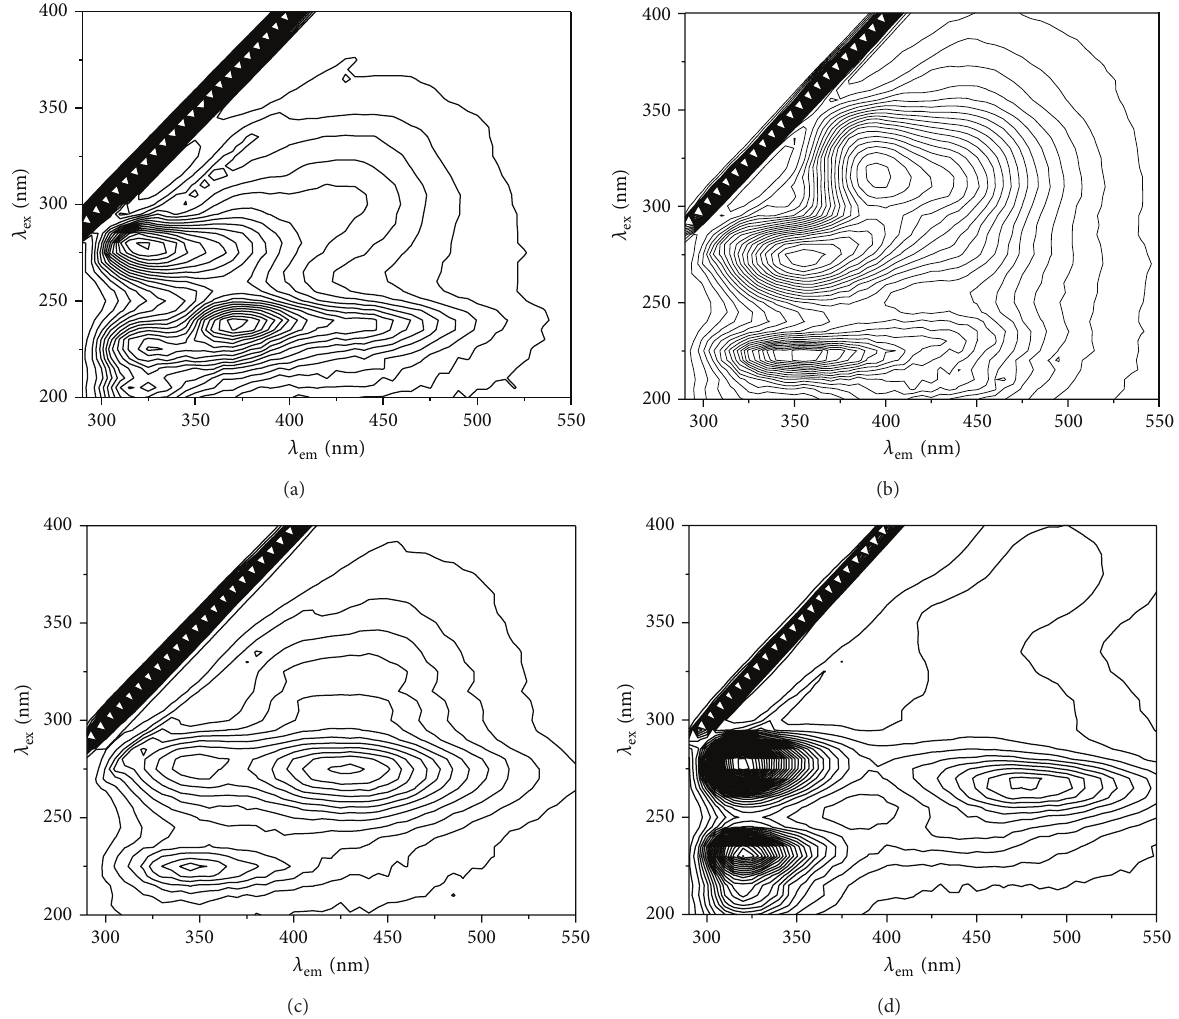
Figure 5: 3D fluorescence spectra of four kinds of Chinese herbal medicines in CDC. (a) Xihuangcao, c : 400 𝜇 gmL −1 ; (b) Yinchen, c : 400 𝜇 gmL −1 ; (c) Chuanxinlian, c : 400 𝜇 gmL −1 ; (d) Dahuang, c : 100 𝜇 g mL −1 . Contour interval: